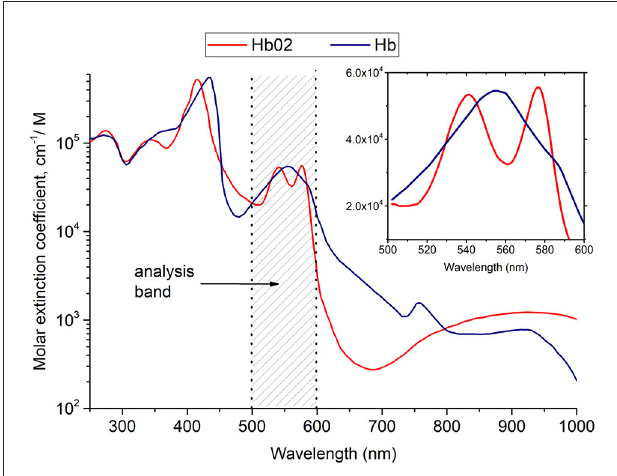
FIGURE2 Results of hemoglobin oxygenation measurement in the microcirculatory supply of periodontal tissues.